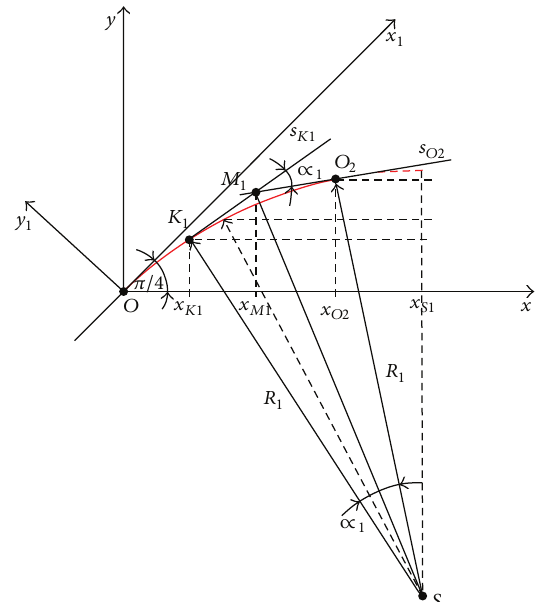
Figure 2: Diagram illustrating the position of circular arc